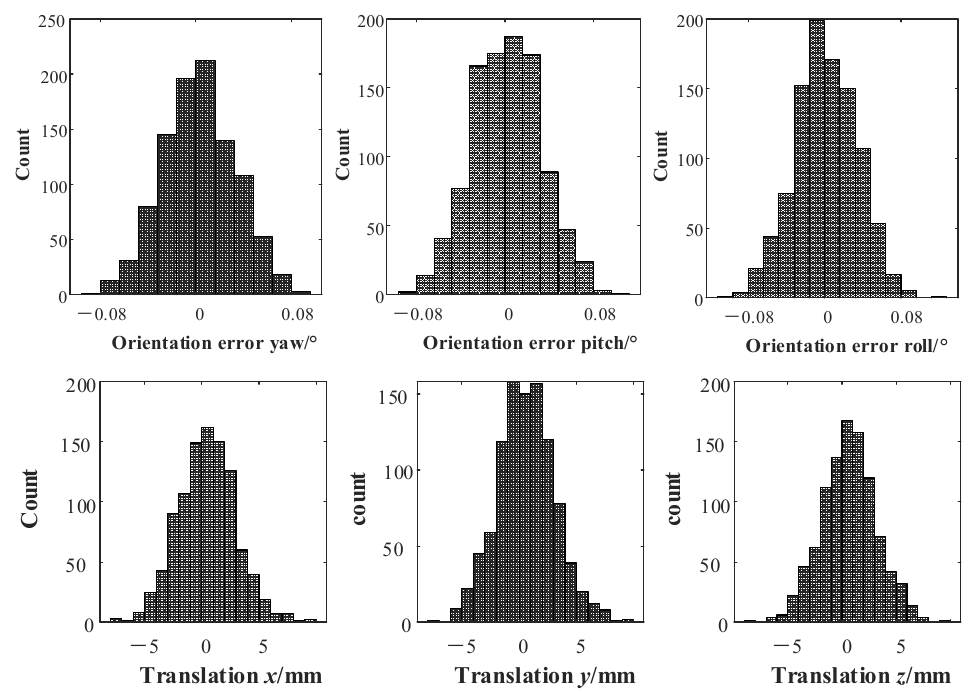
Figure 8. Statistical histogram of calibration errors of IMU and LiDAR external parameters.